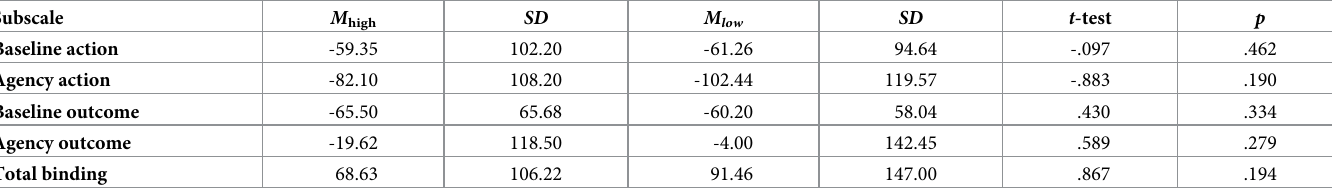
One-tailed t -tests for intentional binding conditions, first (high, N = 44) versus fourth (low, N = 56) percentiles in the narcissism subscale scores for classic narcissistic